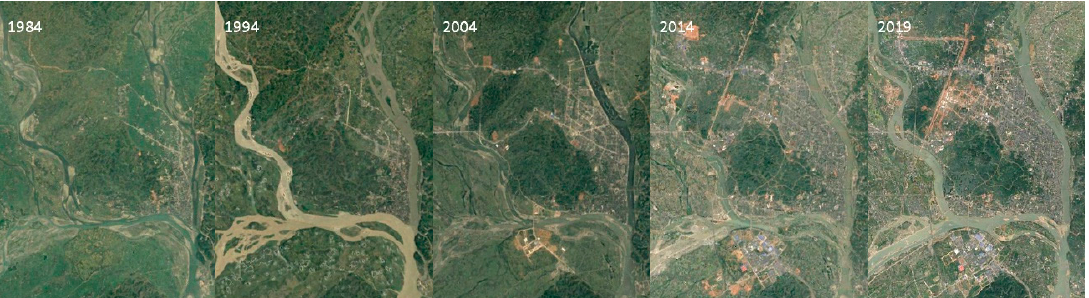
Figure 1. Urban expansion from 1984 to 2019 in LS (Google Maps).